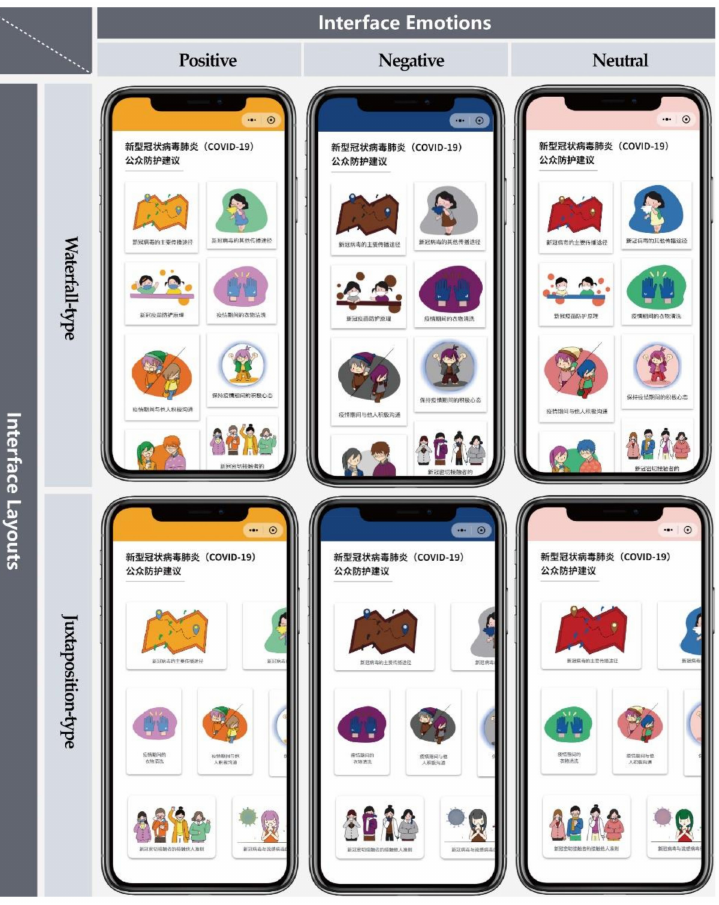
Figure 4. Homepages of the 6 interfaces designed in this research (in Chinese). Participants can click on each information module to learn more about virus protection